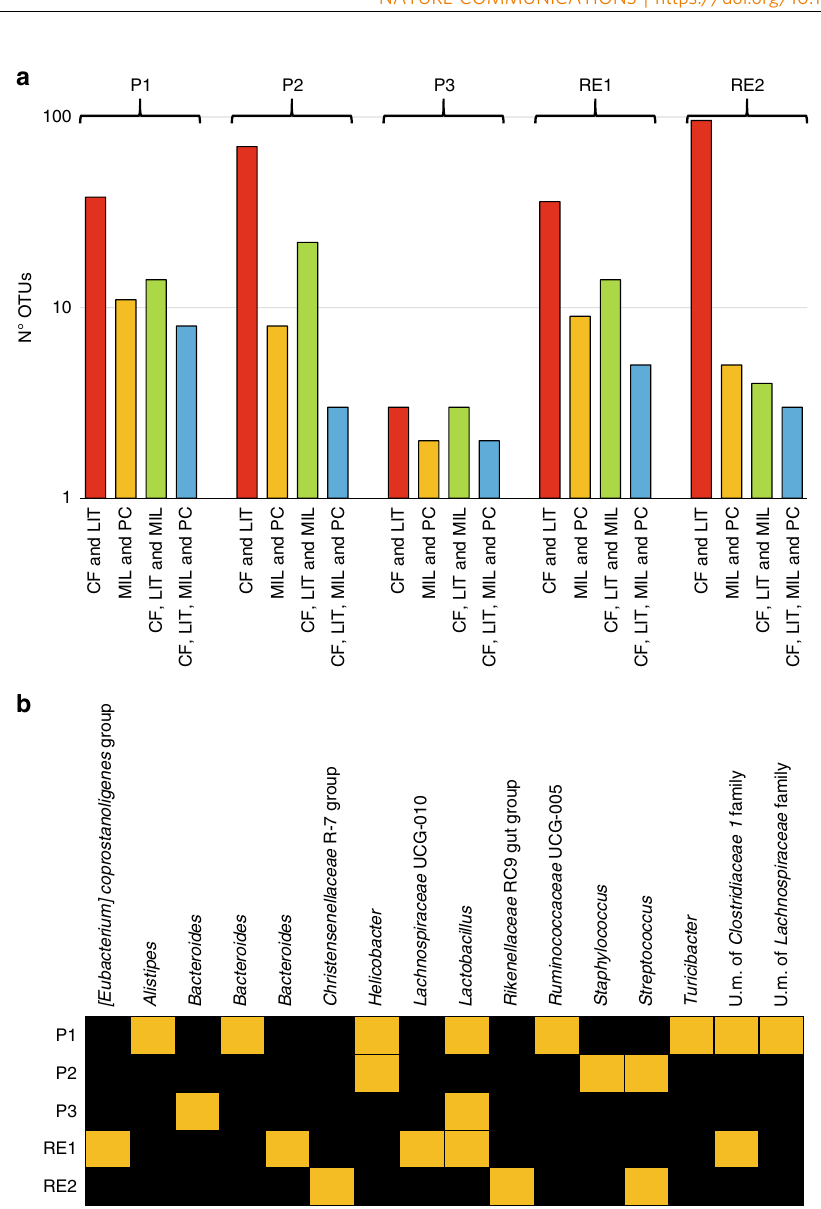
Fig. 2 16S rRNA gene-based OTU analysis surveying possible microbial transmission events. Panel a shows a bar plot of the number of 16S rRNA gene OTUs shared between multiple matrices (prevalence of >70%) collected from the same cheese making site. Panel b reports a heat map of the bacterial taxa for which OTUs have been found to be shared with a prevalence of >70% by CF, LIT, MIL, and PC samples of the same cheese production site. Source data are provided as a Source Data fi